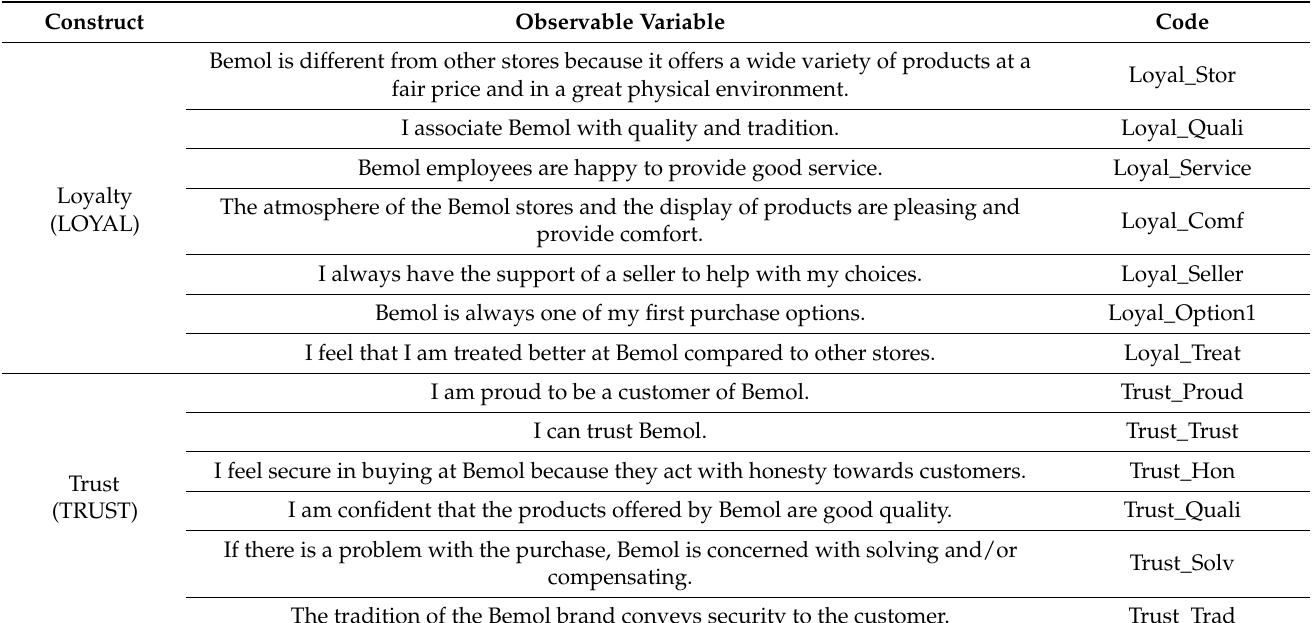
Table 1. Observable and latent